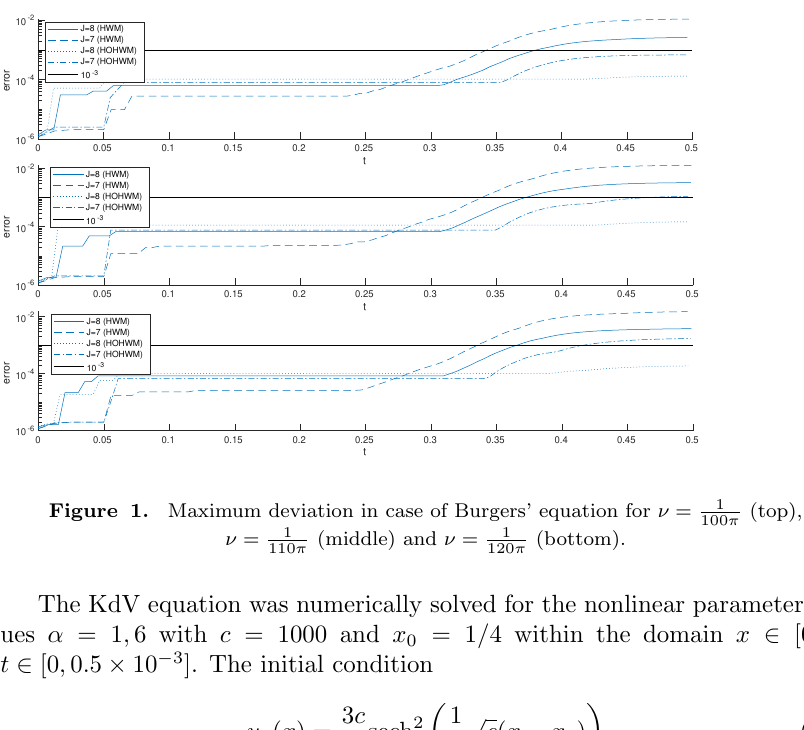
Figure 1. Maximum deviation in case of Burgers’ equation for ν = 1